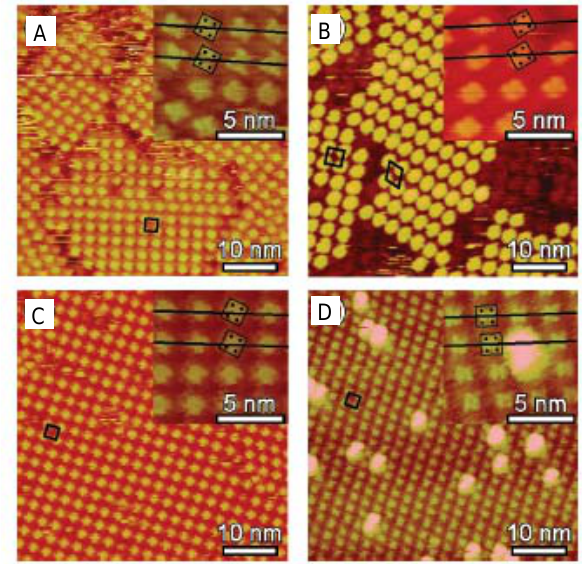
Figure 15. STM images of double-decker complexes at the solution–HOPG interface. Reprinted with permission from reference [74]. Copyright 2009 American Chemical